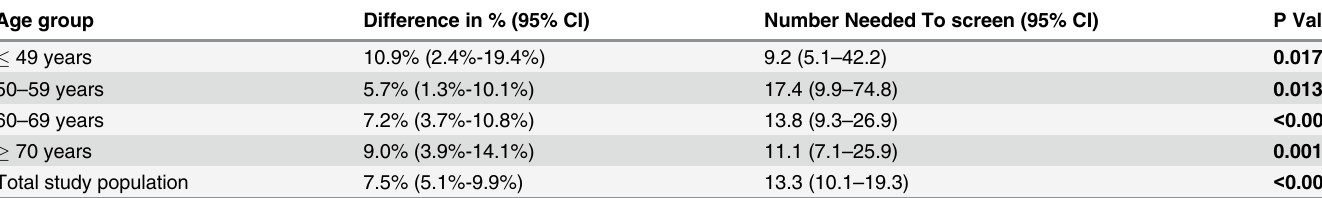
S1 Table. Sensitivity and specificity of different cut-off value scenarios, stratified by age cat- egories.